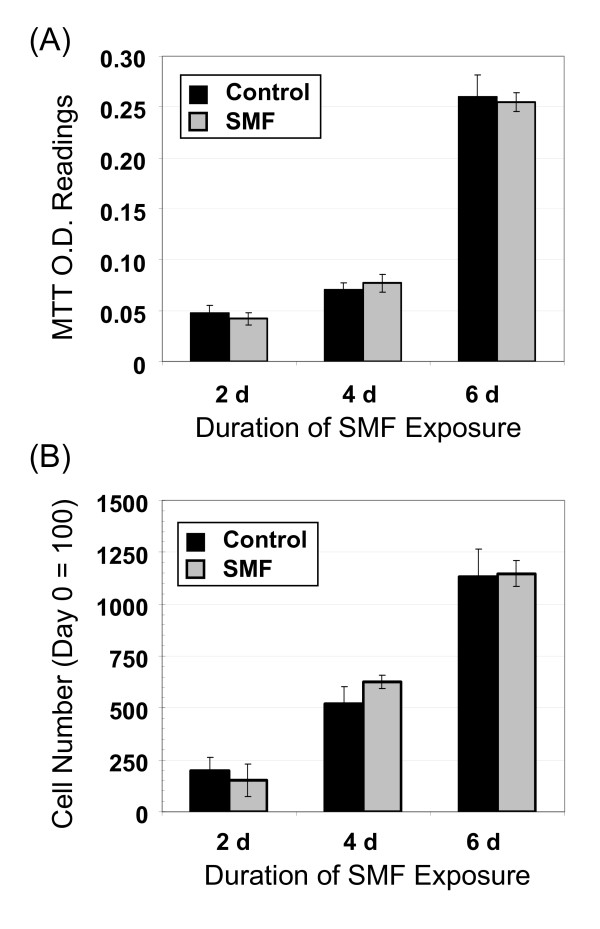
Proliferation is not altered by SMF in HEK AD293 cells. The cell line dependence of SMF effects is illustrated by the lack of a response in SMF-treated HEK AD293 cells when proliferation was measured by the MTT assay (Panel A) or by cell counts (Panel B). Error bars represent SD for n ≥ 3 independent experiments and in all cases p > 0.05.